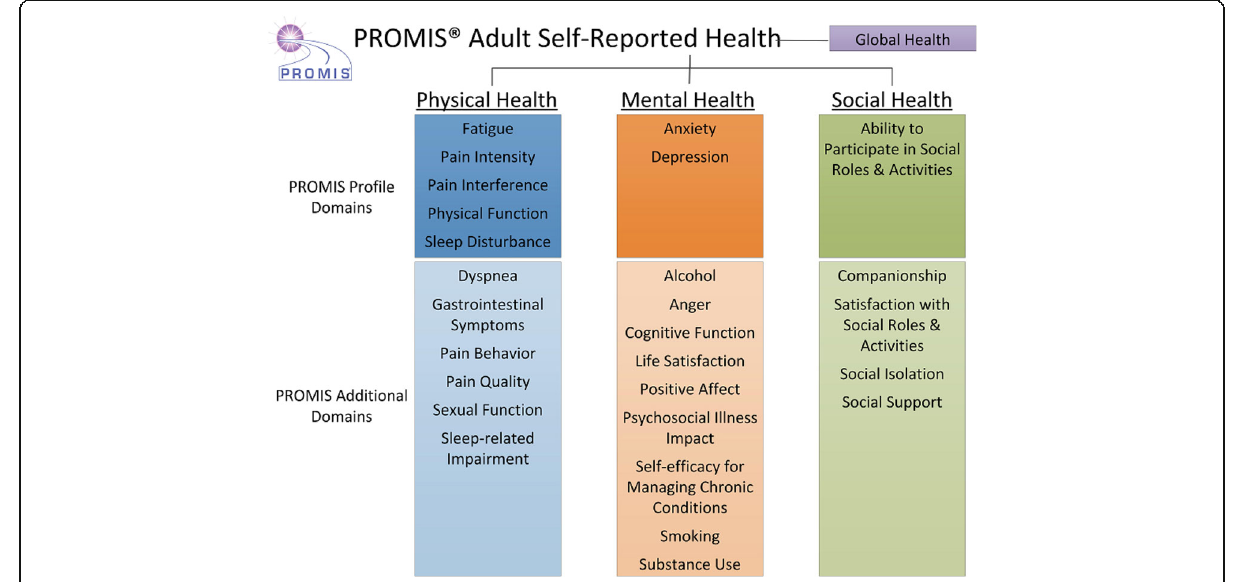
Fig. 2 PROMIS Domain Framework for Health-Related Quality of